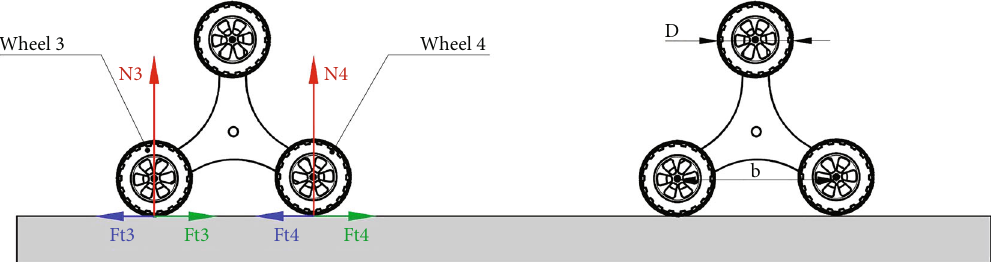
Figure 5: Mechanical analysis of planetary gears without obstacles.